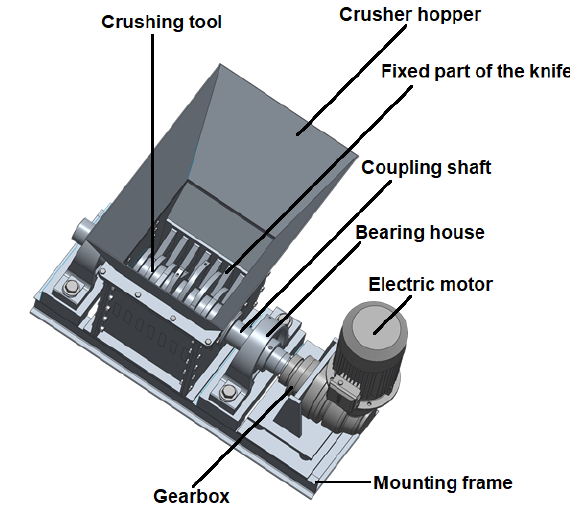
Figure 1 Position of the cutting mechanism in the crusher The arrangement of the crushing tools affects the